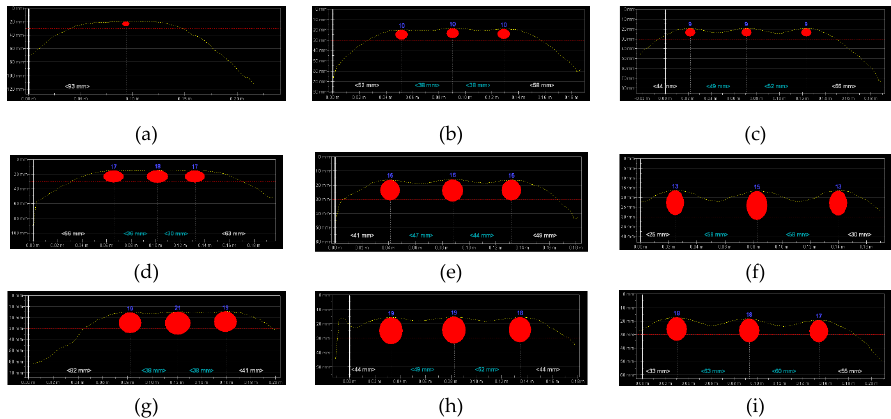
Figure 19. Results from tests performed with the electromagnetic device (2): ( a ) S-10-20 (result: one bar, ø obs = 8 mm, c obs = 20 mm), ( b ) S-10-30 (three rebars, ø obs = 10 mm, c obs = 19.3, mm), ( c ) S-10-40 (three rebars, ø obs = 9 mm, c obs = 19.3 mm), ( d ) S-16-20 (three rebars, ø obs = 17 mm, c obs = 15.5, mm), ( e ) S-16-30 (three rebars, ø obs = 15 mm, c obs = 16.4, mm), ( f ) S-16-40 (three rebars, ø obs = 14 mm, c obs = 16.5, mm), ( g ) S-20-20 (three rebars, ø obs = 19 mm, c obs = 15 mm), ( h ) S-20-30 (three rebars, ø obs = 19 mm, c obs = 15.4 mm), and ( i ) S-20-40 (three rebars, ø obs = 18 mm, c obs = 18.3 mm).